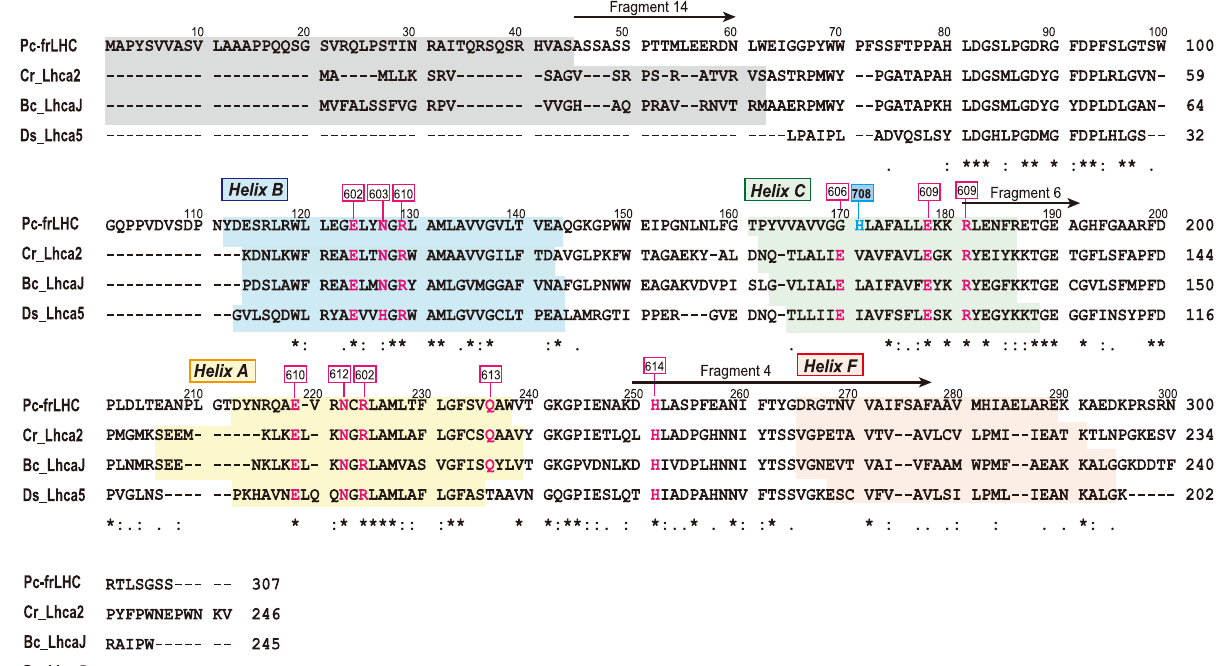
Fig. 2 | Sequence alignment of Pc-frLHC from P. crispa and the closely related LHCs. ThededucedaminoacidsequenceofPc-frLHCwasclassi fi edintooneofthe LHCI groups along with Lhca2 of Chlamydomonas reinhardtii (Cr_Lhca2), Lhca-J of amarinegreenalga, Bryopsiscorticulans (Bc_LhcaJ),andLhca5ofahalophilicgreen alga, Dunaliellasalina (Ds_Lhca5)withamino acidsequenceidentities of 32%,32%, and 29%, respectively. Recent analyses revealed that Cr_Lhca2, Bc_LhcaJ, and Ds_Lhca5 are orthologs and loosely bound to the side of green algal PSI in a het- erodimeric state together with Cr_Lhca9, Bc_LhcI, and Ds_Lhca6, respectively 24 – 28 . On the basis of these results, we concluded that Pc-frLHC is phylogenetically a